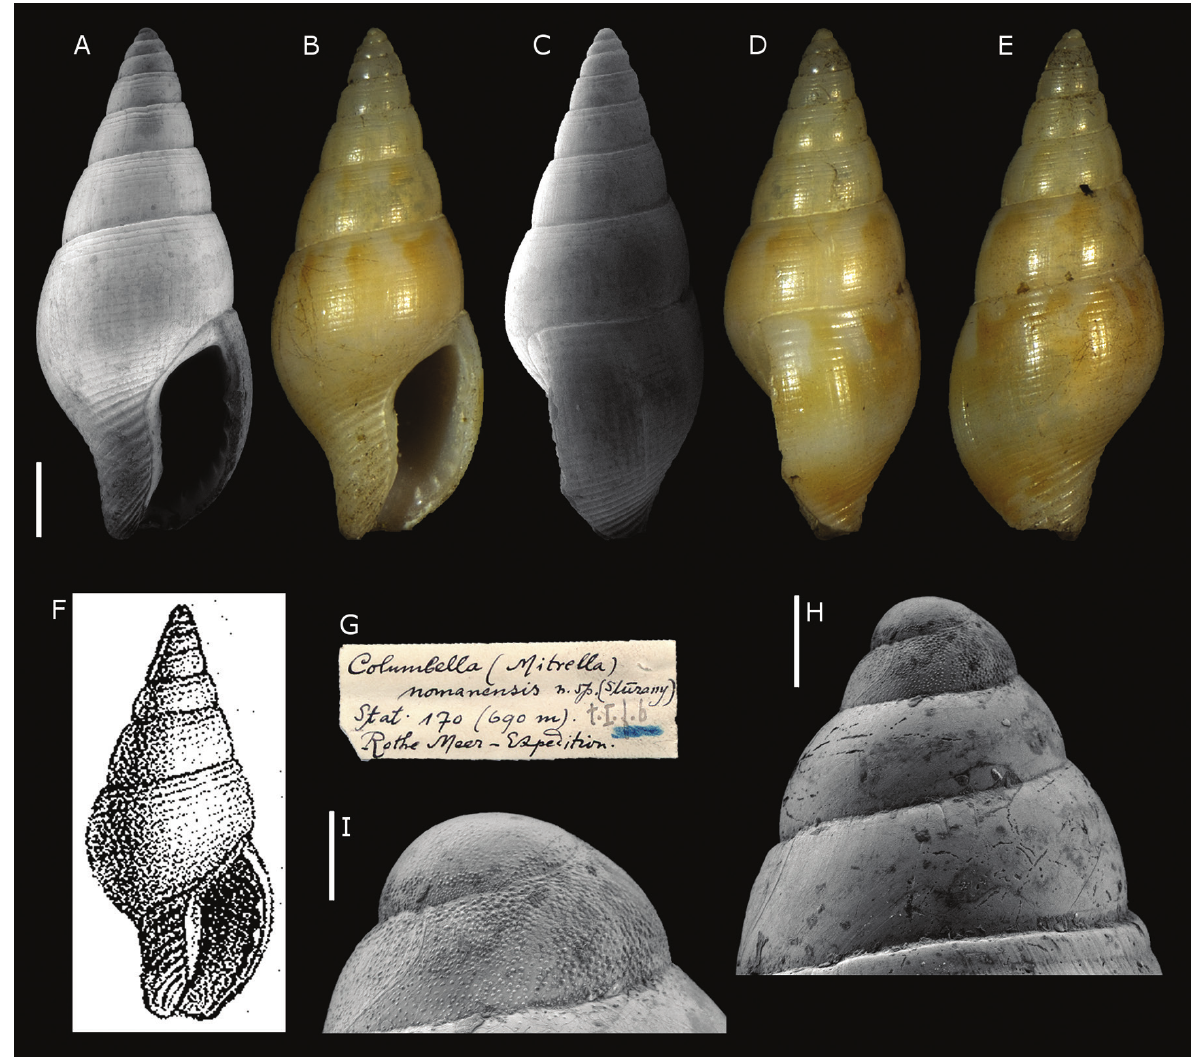
Figure 10. Columbella nomanensis Sturany, 1900, Station 170 (Noman Island, Saudi Arabia, Red Sea). A–E, H–I. Holotype, NHMW 84222: front ( A–B ), right side ( C–D ), back ( E ), protoconch ( H–I ). F . Original figure by Sturany (1903). G . Original holo-